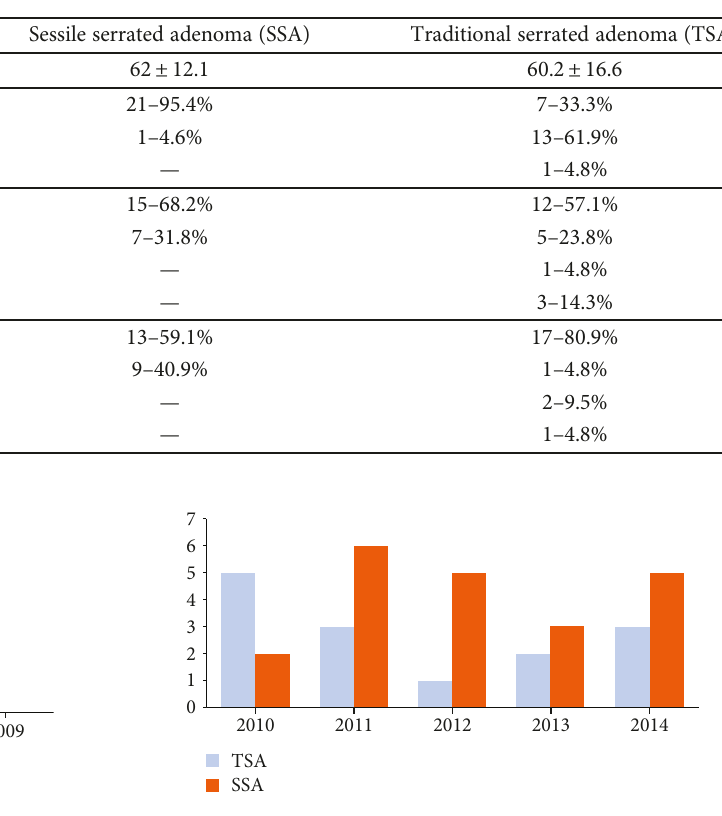
Table 2: Descriptive analysis of serrated lesions. The distribution of the serrated lesions according to their general aspects: the mean age, localization, and size and morphological characteristics.